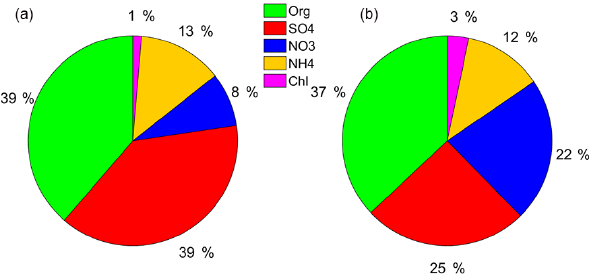
Figure 8. Aerosol mass fractions of PM 1 measured by the ACSM for (a) Case I and (b) Case